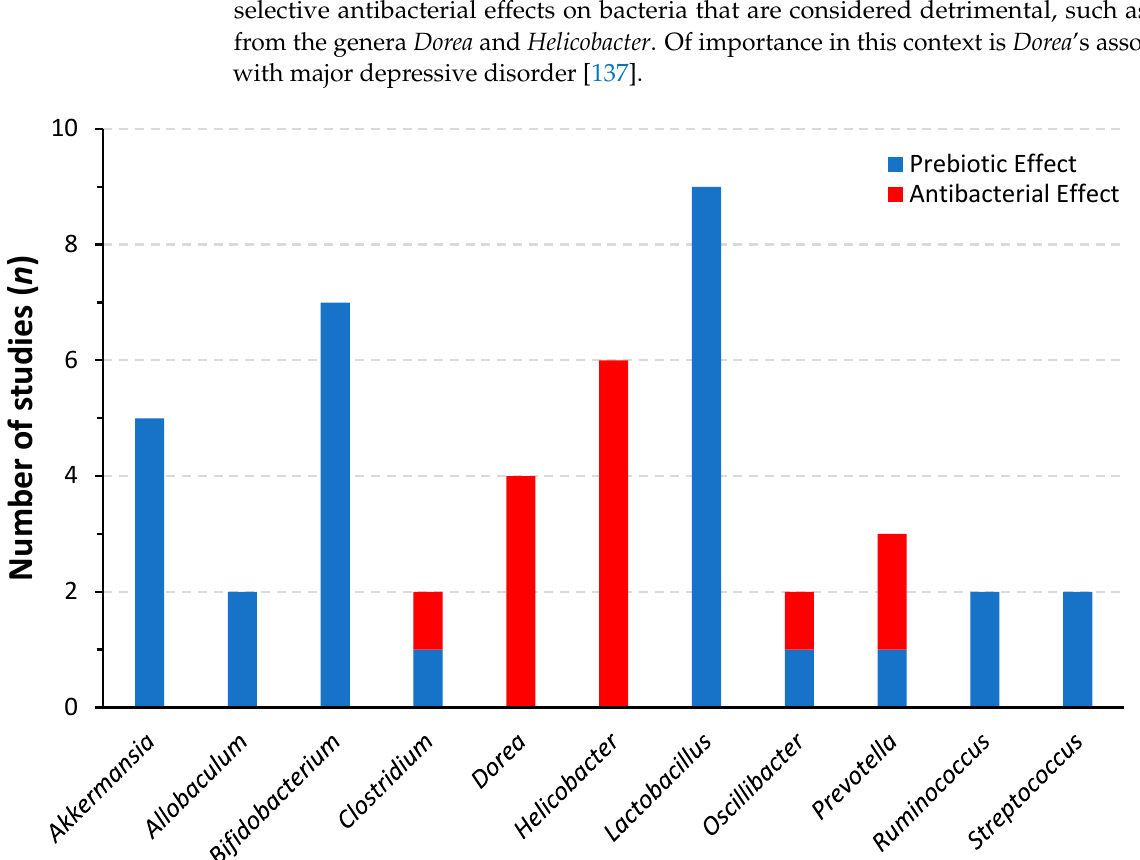
Figure 2. Reported prebiotic and antibacterial effects of ginseng and ginsenosides on microbial gen- era.